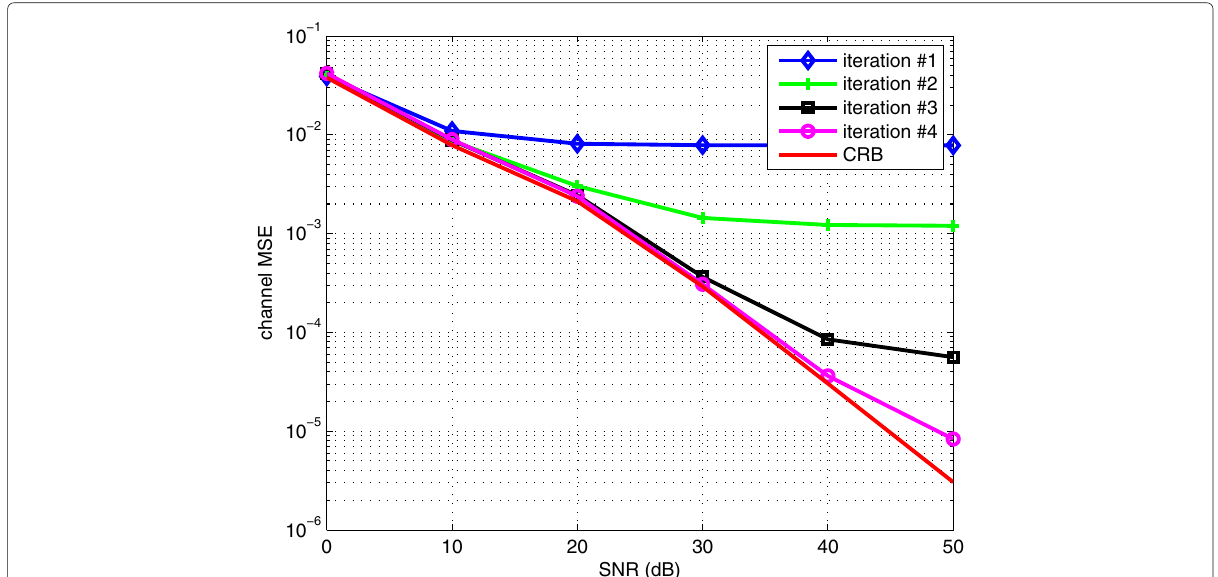
Fig. 4 Performance of the CML estimator as a function of the SNR for SIR = 0 dB, K =